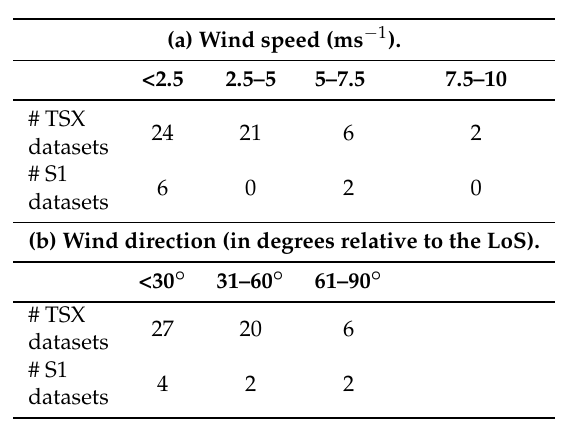
Table 4. Wind speed and wind direction during the data